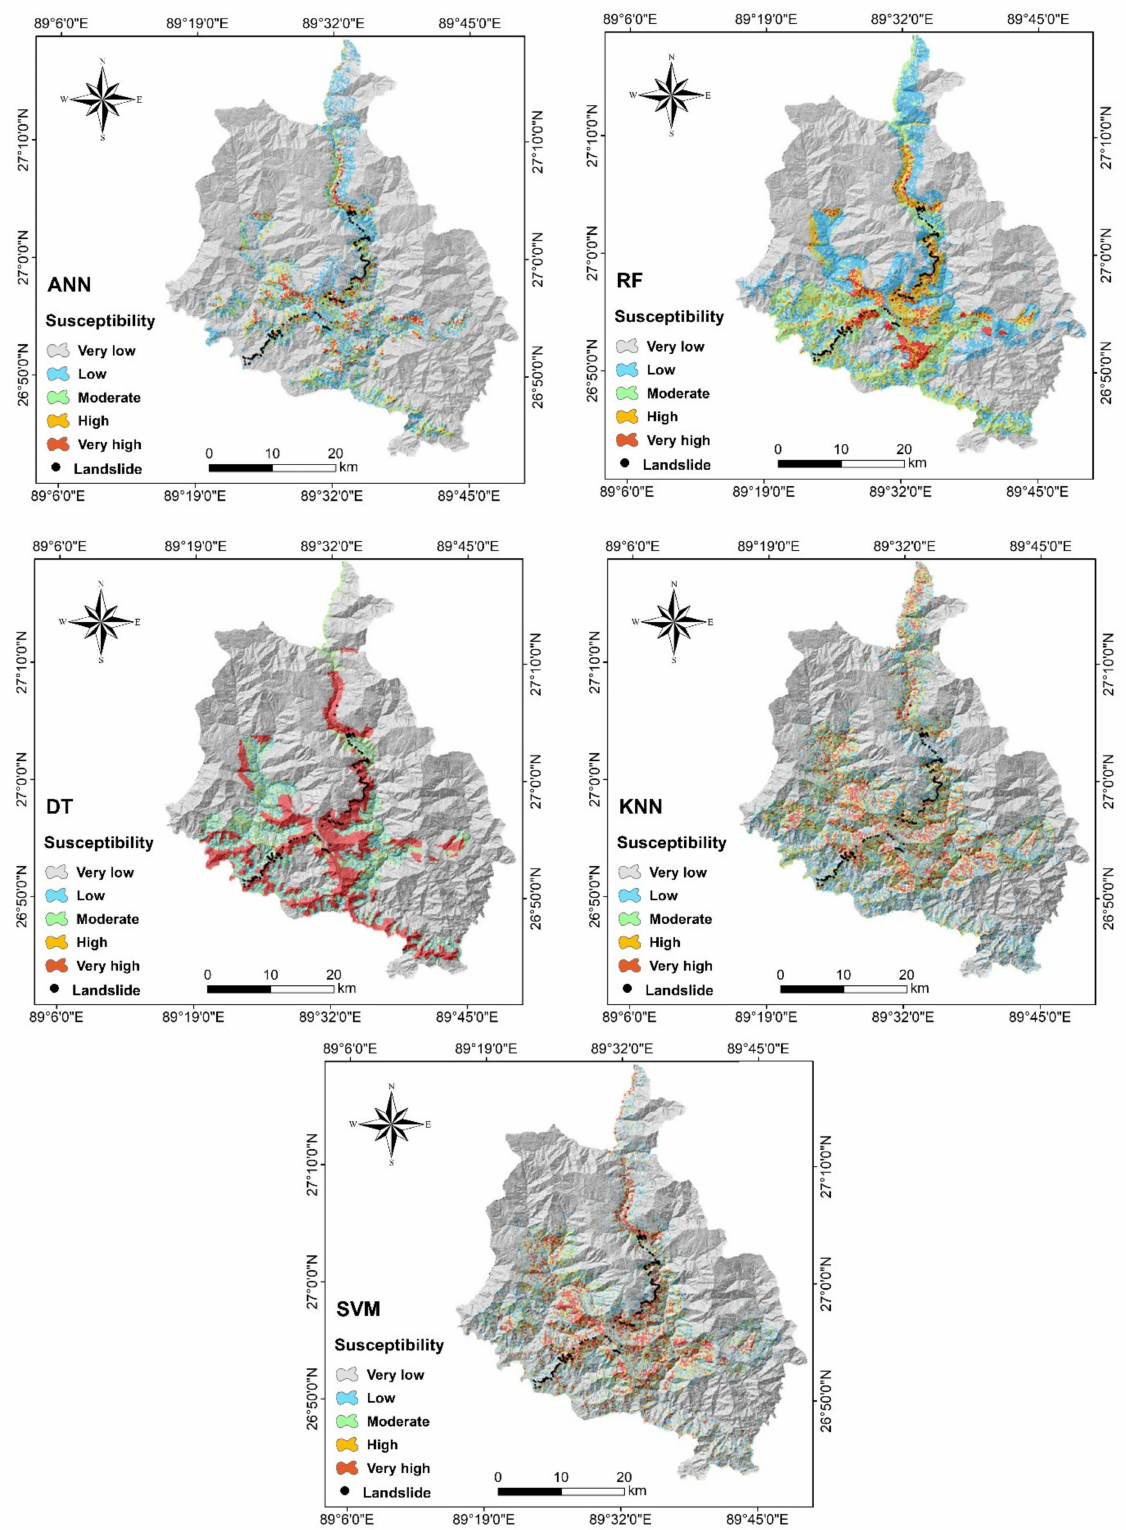
Figure 7. Landslide susceptibility maps produced by ANN, RF, DT, kNN, and SVM models using the corrected datasets created by the proposed